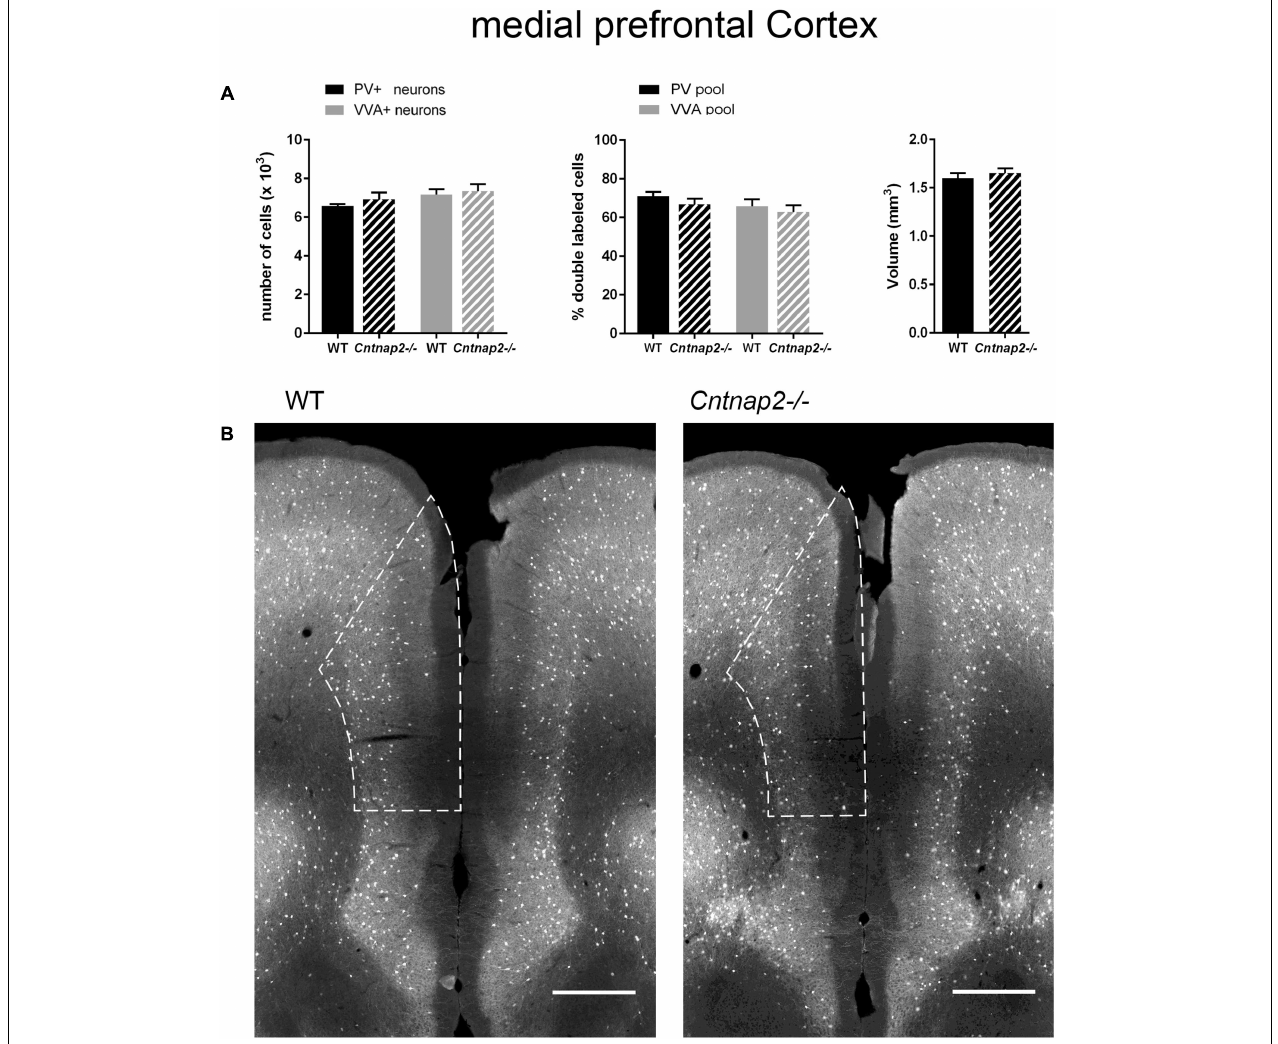
FIGURE 4 | (A) Left: Stereological estimations of PV + (black) and VVA + (gray) cells in the mPFC of PND25 WT ( N = 6) and Cntnap2–/– ( N = 5) mice. Middle: percentage of PV + cells surrounded by VVA (black) and VVA + cells showing PV expression (gray) in WT and Cntnap2–/– mice. Right: Volume of the ROI; i.e., the mPFC. (B) Representative PV immunofluorescence images from the mPFC of a WT and Cntnap2–/– mouse. ROIs are indicated with dashed lines (sections are located at Bregma 1.70 mm). Scale bar: 500 µ m. All data are expressed as mean ±